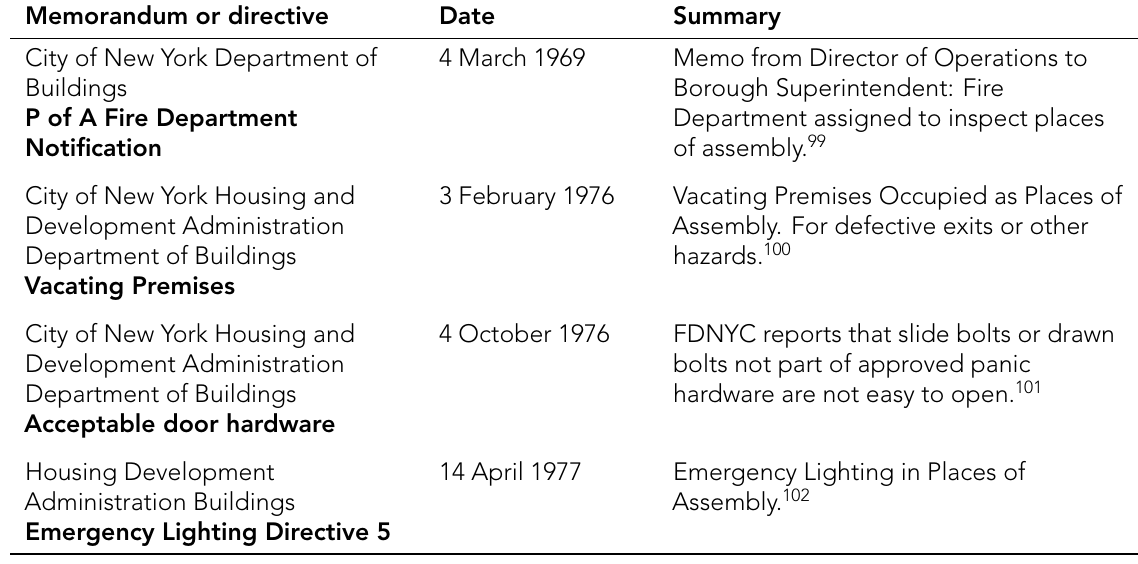
Table 2. Memoranda and directives added to current Places of Assembly building codes (Source: